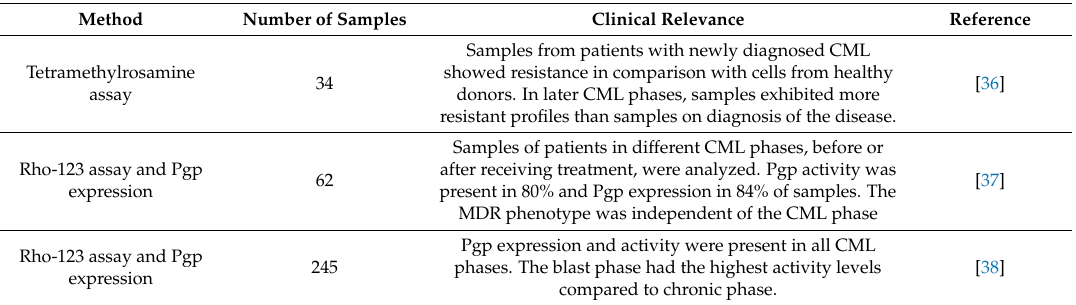
Table 1. ABCB1 /Pgp/expression/activity in samples from chronic myeloid leukemia